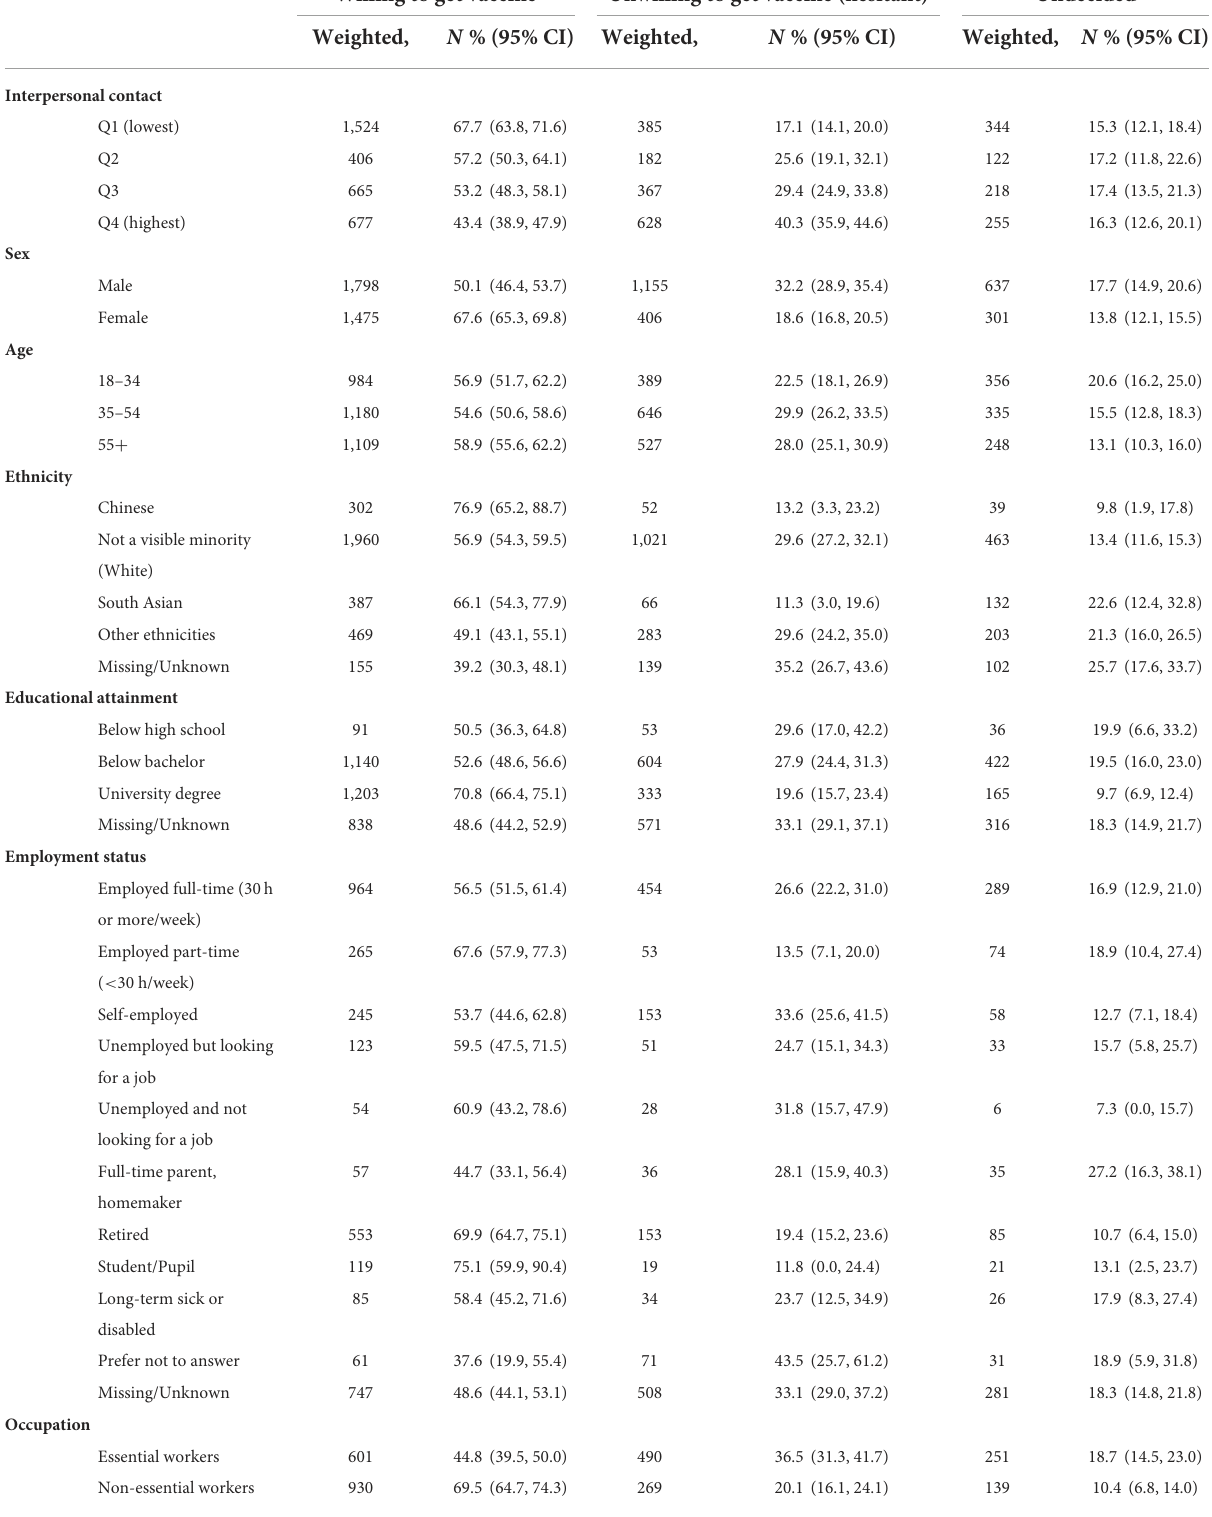
TABLE 3 Characteristics of study participants by vaccine hesitancy (unweighted, N = 4,515), March 8, 2021-December 6, 2021. Willing to get